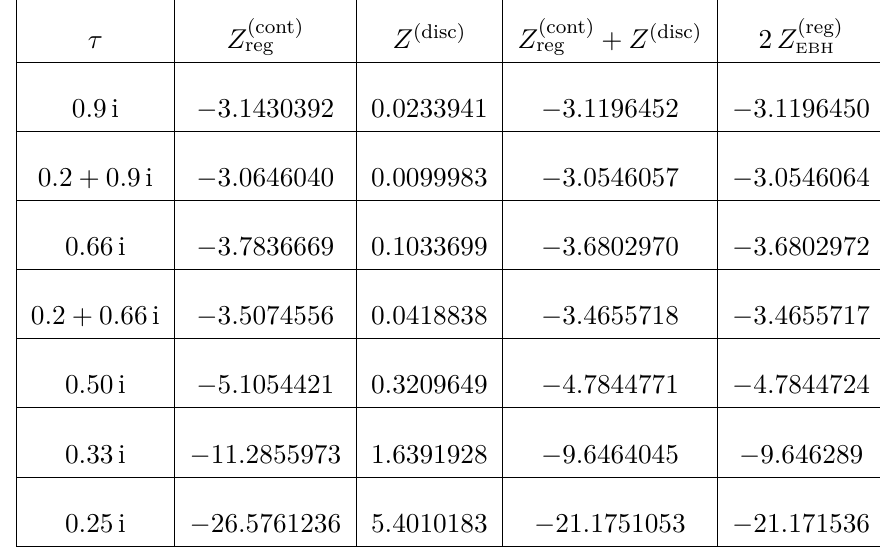
(8.14) with the parameters set to EBH